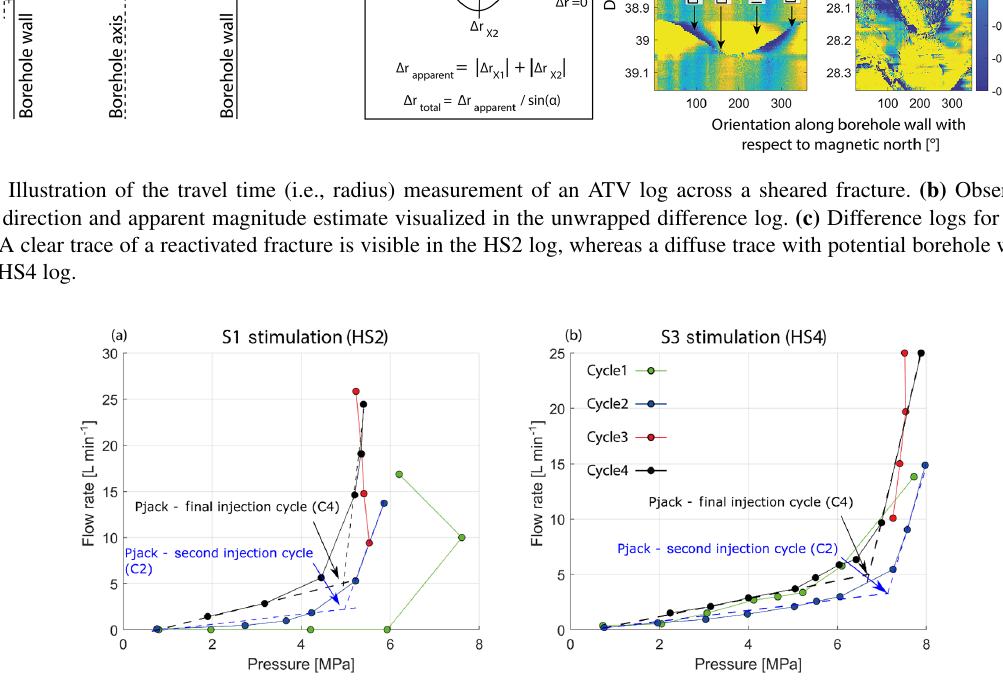
Figure 6. Cross-plots of flow versus pressure data for the four injection cycles of the S1 and S3 stimulation experiment in (a) and (b) , respectively. The points defining the curves for each cycle denote flow–pressure data pairs defined at the end of each step of the test in question. The first cycle frequently reaches high pressures, which may reflect the inelastic processes of the breakage of cohesive bonds and/or the slippage of fractures supporting shear stress. In subsequent cycles, the response to pressurization is largely elastic and